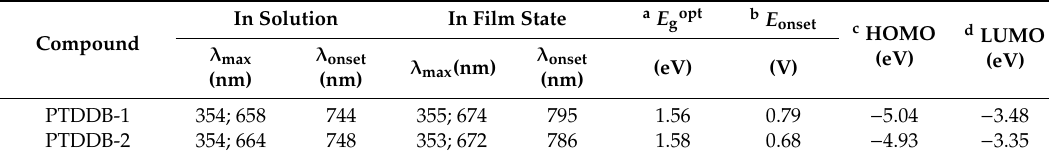
Table 2. Summary of optical and electrochemical properties of copolymers PITID-X (X = 1, 2) in solution and as film